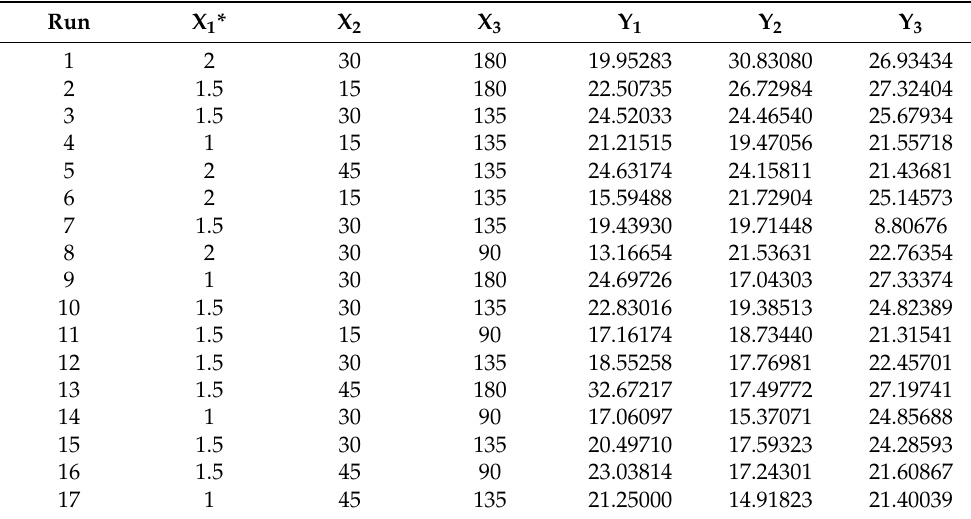
Table 2. Experimental values of response variables for Box–Behnken